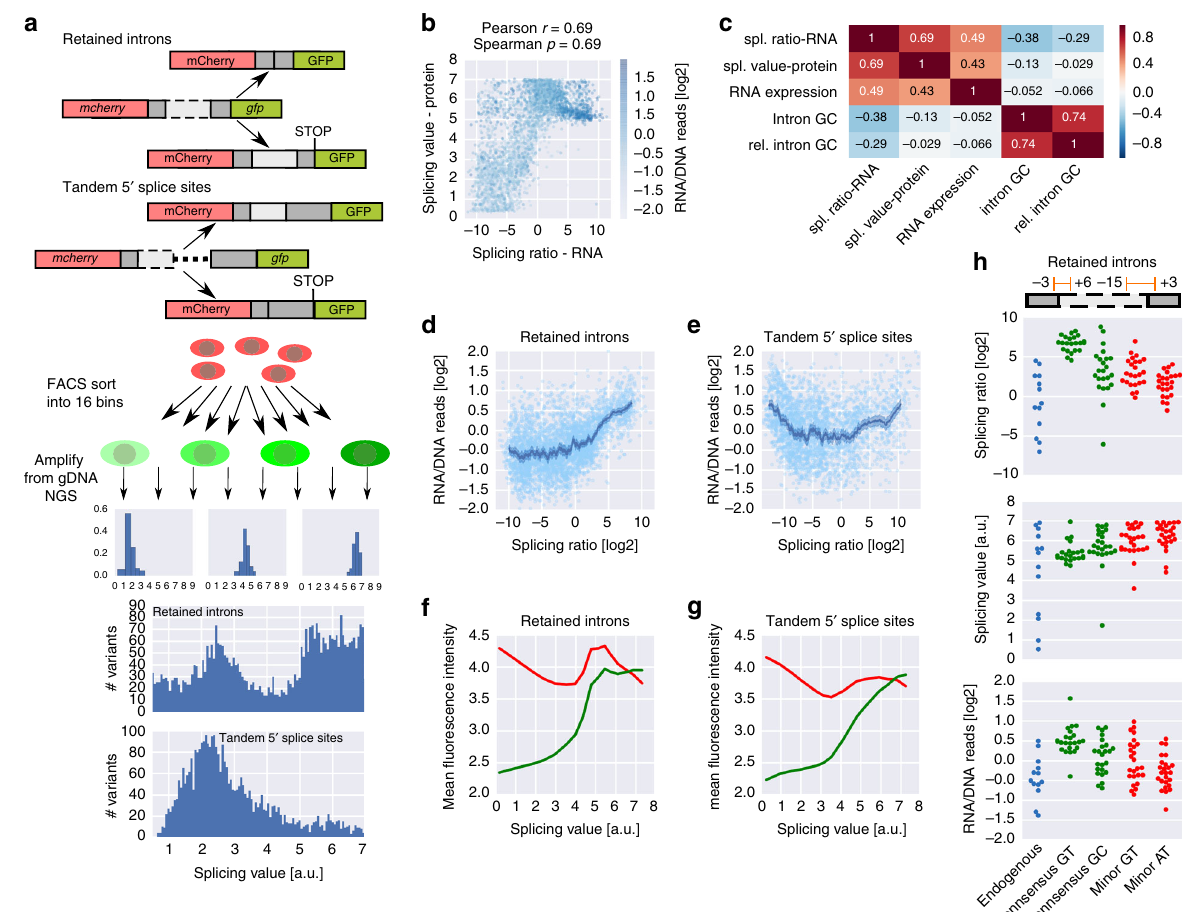
Fig. 5 Quantifying protein isoform ratios reveals differential posttranscriptional fates. a Outline of the experimental pipeline for obtaining protein-based splicing measurements for retained introns and tandem 5 ′ splice sites. b RNA-based splicing ratios plotted against protein-based splicing values for the retained intron library; the color intensity denotes the RNA expression levels (dark blue corresponds to high and light blue to low RNA expression levels (log2(RNA/DNA reads)). c Pearson correlation coef fi cients between RNA-based splicing ratios, protein-based splicing values, RNA expression levels (log ratio of RNA/DNA reads), intronic GC content and relative intronic GC content (normalized to the GC content of the surrounding exons). d , e Log ratios of RNA/DNA reads ( = RNA expression levels) plotted against splicing ratios for the retained intron ( d ) and tandem 5 ′ splice sites ( e ) library. f , g Mean mCherry (red) and GFP (green) fl uorescence intensity for cells from the retained intron ( f ) or tandem 5 ′ splice sites library ( g ) sorted into each of the 16 bins are plotted against the respective splicing value (i.e., the median log ratio of GFP/mCherry fl uorescence intensity). h Data points denote the RNA- based splicing ratios (top), protein-based splicing values (middle) and log ratios of RNA/DNA reads (bottom) of individual variants with the indicated sequence (endogenous or a consensus sequence) at donor and acceptor splice sites ( n = 22 – 59); green indicates processing by the major and red processing by the minor